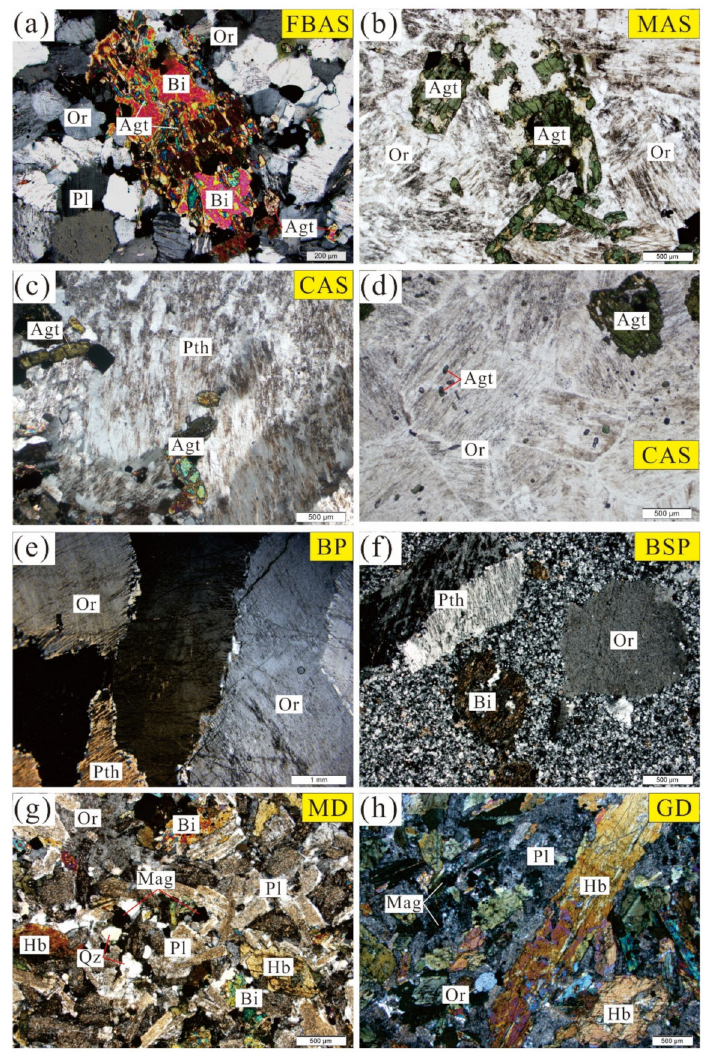
Figure 4. Photomicrographs of the Hongshan complex. ( a ) The FBAS, showing the residual Agt metasomatized by Bi; ( b ) The MAS, showing the euhedral and subhedral columnar Agt; ( c , d ) the CAS, showing the residual Agt and the fine-grained Agt; ( e ) the SP; ( f ) the BSP; ( g ) The MD; ( h ) the GD; Or: orthoclase, Bi: biotite, Pl: plagioclase, Agt: aegirine-augite, Pth: perthite, Hb: hornblende, Mag: magnetite. ( b , d ) are photographs under plane-polarized light. ( a , c , e – h ) are photographs under cross-polarized